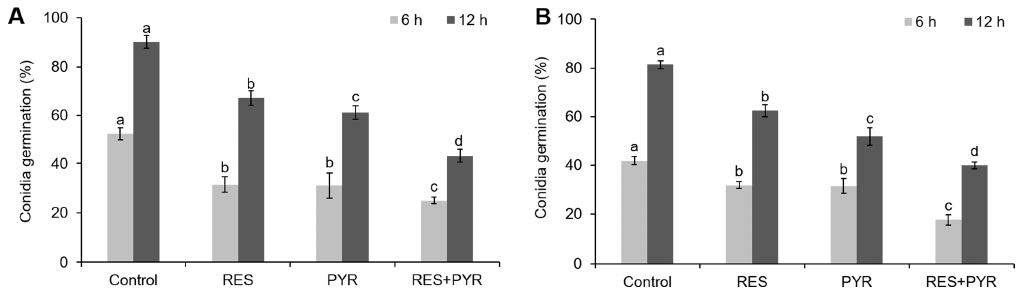
Figure 2. Suppression of B. cinerea conidia germination by resveratrol and pyrimethanil. Conidia suspension of B. cinerea isolate TGM ( A ) and BRB ( B ) was subject to different drug treatment and the conidia germination was measured at 6 h and 12 h post incubation. RES and PYR represent resveratrol and pyrimethanil used alone, respectively. RES+PYR represent resveratrol and pyrimethanil used in combination. Data was presented as mean ± SE (standard error), and same set of columns followed by different letters indicate significant ( P < 0.05) differences according to Duncan’s multiple range test.